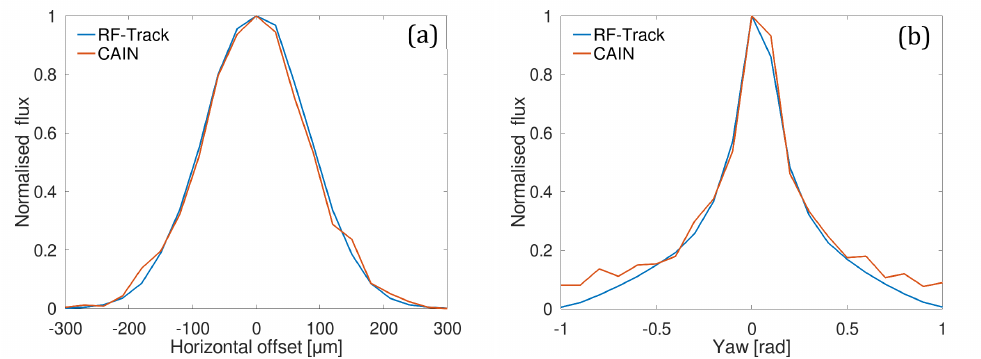
Figure 10. Comparison of ThomX horizontal offset scans obtained in RF-Track and CAIN, given a 0 crossing angle. Total flux results were normalised with respect to the maximum value. ( a ) Horizon- tal offset scans. ( b ) Yaw offset